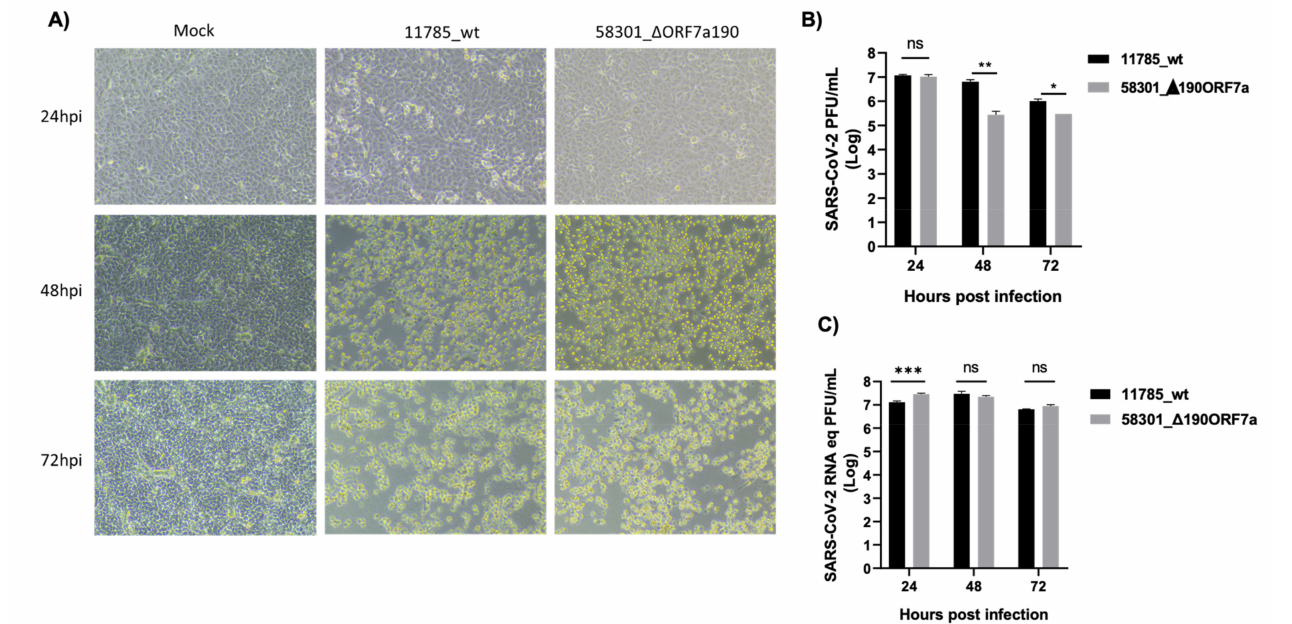
Figure 4. SARS-CoV-2 ORF7a 190-nt deletion reduces virus infectivity in Vero E6 cells. ( A ) Vero E6 cells were infected at MOI of 0.1 of SARS-CoV-2_wt (11785_wt) or SARS-CoV-2_ORF7a_ ∆ 190 (58301_ORF7a_ ∆ 190). ( B ) Cell supernatant was collected at 24, 48 and 72 hpi and used for virus titration in Vero E6 cells. Virus titration (mean ± SD) was plotted in a graphic. The virus titles at each time point were compared using multiple unpaired t-tests. PFU = plaque forming units ( C ) Cell supernatant was collected at 24, 48 and 72 hpi and used to perform RT-qPCR for SARS-CoV-2 N. SARS-CoV-2 RNA equivalent to PFU (mean ± SD) was plotted in the graphic. The virus titrations at each time point were compared using multiple unpaired t -tests. Results are from three independent experiments. * p < 0.05; ** p < 0.01; *** p < 0.001; ns indicates no significant difference ( p >